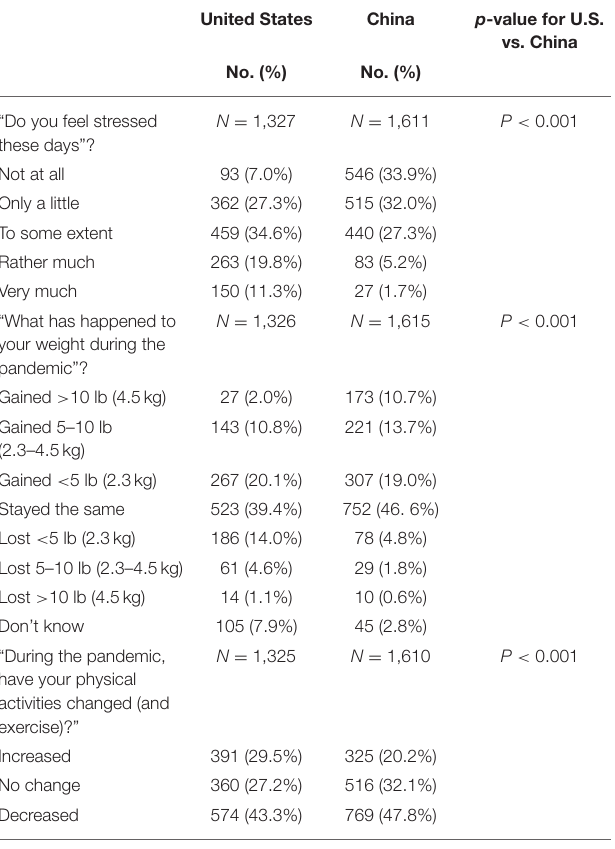
TABLE 2 | Stress level and body weight change during the COVID-19 pandemic as reported by U.S. and Chinese participants. United States China p -value for U.S. vs.